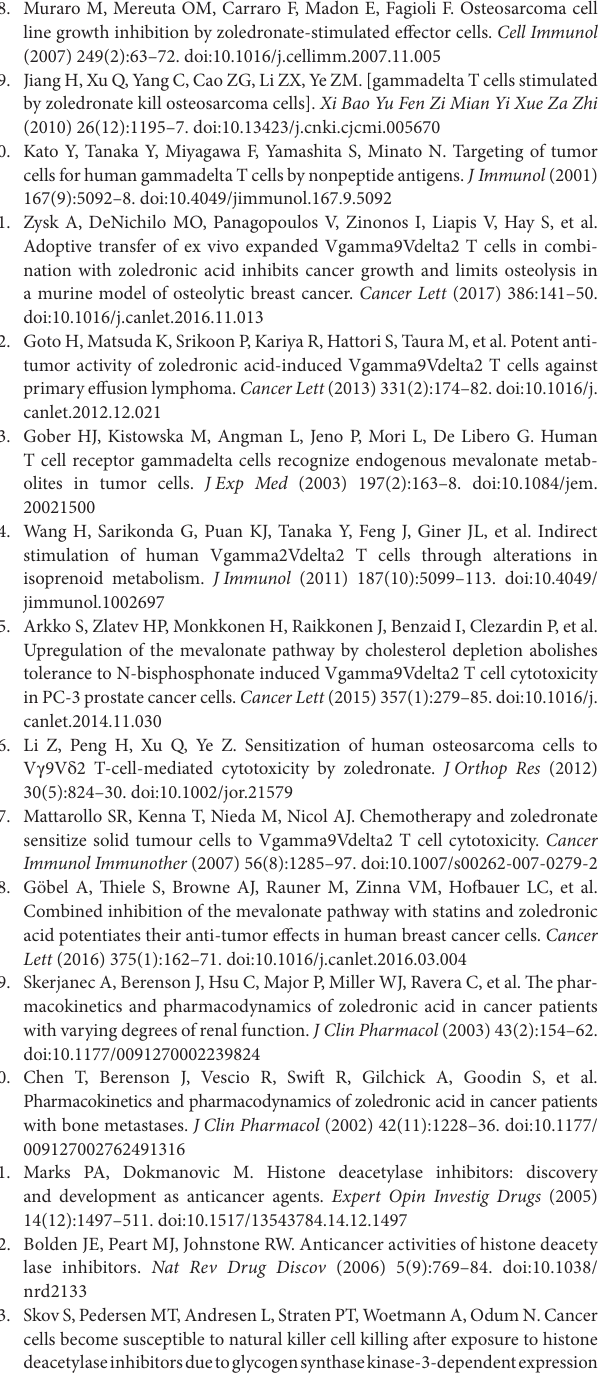
FigUre s1 | Ex vivo expansion of γδ T cells. Representative flow cytometry of γδ T cells from volunteers after 14 days culture and magnetic beads separation. FigUre s2 | Valproic acid (VPA) and/or zoledronate (ZOL) under a certain concentration showed little cytotoxicity on four osteosarcoma cell lines. HOS, U2OS, MG63, and Saos2 cells were treated for 24 h with different concentrations of VPA and ZOL at a certain ratio. Then the cell viability was measured by MTS